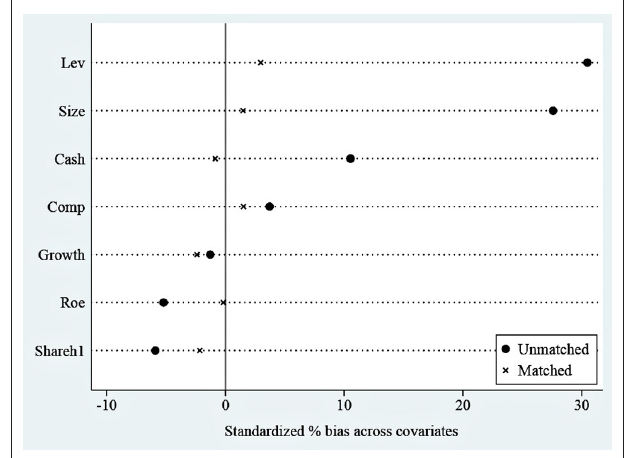
FIGURE 3 | The results of the placebo test.